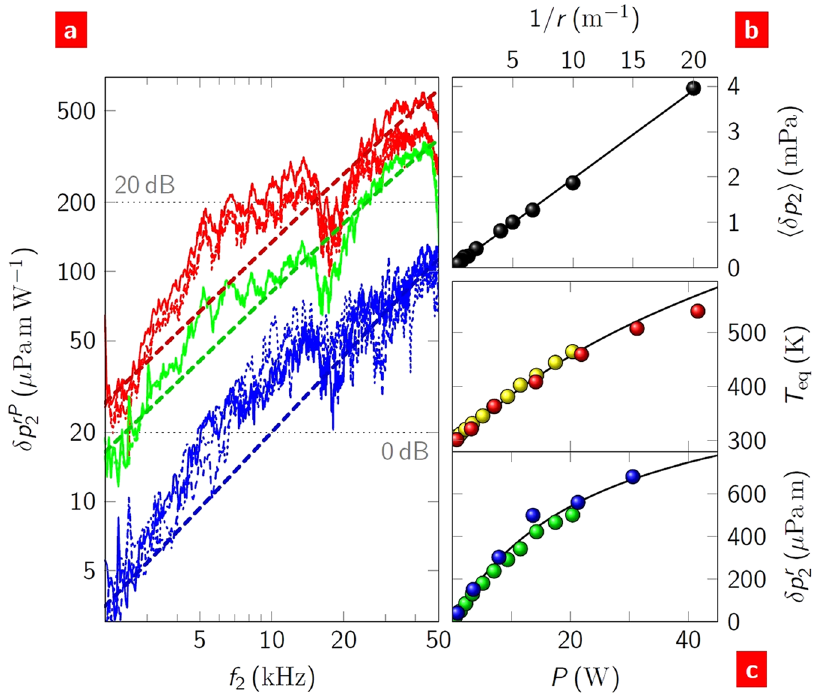
Figure 2. Second harmonic generation. ( a ) Sound pressure spectra from a range of devices (measured at r = 50 mm). The bottom blue group are spectra from four back-gated FETs. The top red group are spectra from four top-gated devices before the electrolyte was deposited. The middle green group are spectra from two top- gated FETs after electrolyte deposition. Different line types designate device data within groups. In all cases, V g = 0. The expected dependences from equation (1) are shown as dashed lines of the same colour as the data. Indicative sound pressure levels, 20log( δ p rf / δ p ref ), where δ p ref = 20 μ Pa m kHz − 1 , are shown as horizontal dotted lines. ( b ) Sound pressure from a back-gated FET with a source power of 3.4 W as a function of inverse device- microphone separation. The sound pressure has been averaged over the frequency range 20–50 kHz. ( c ) (Top) Device temperature measured in two back-gated FETs (differentiated by colour) and calculated (line) as a function of source power. (Bottom) Sound pressure at f 2 = 40 kHz (measured at r = 50 mm) for the same devices. The solid line is the expected dependence from equation